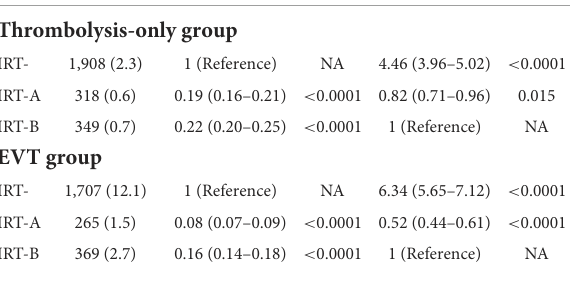
TABLE 3 Cox regression models for the IRT subgroups and all-cause in-hospital mortality in patients with reperfusion therapy. Unadjusted-1